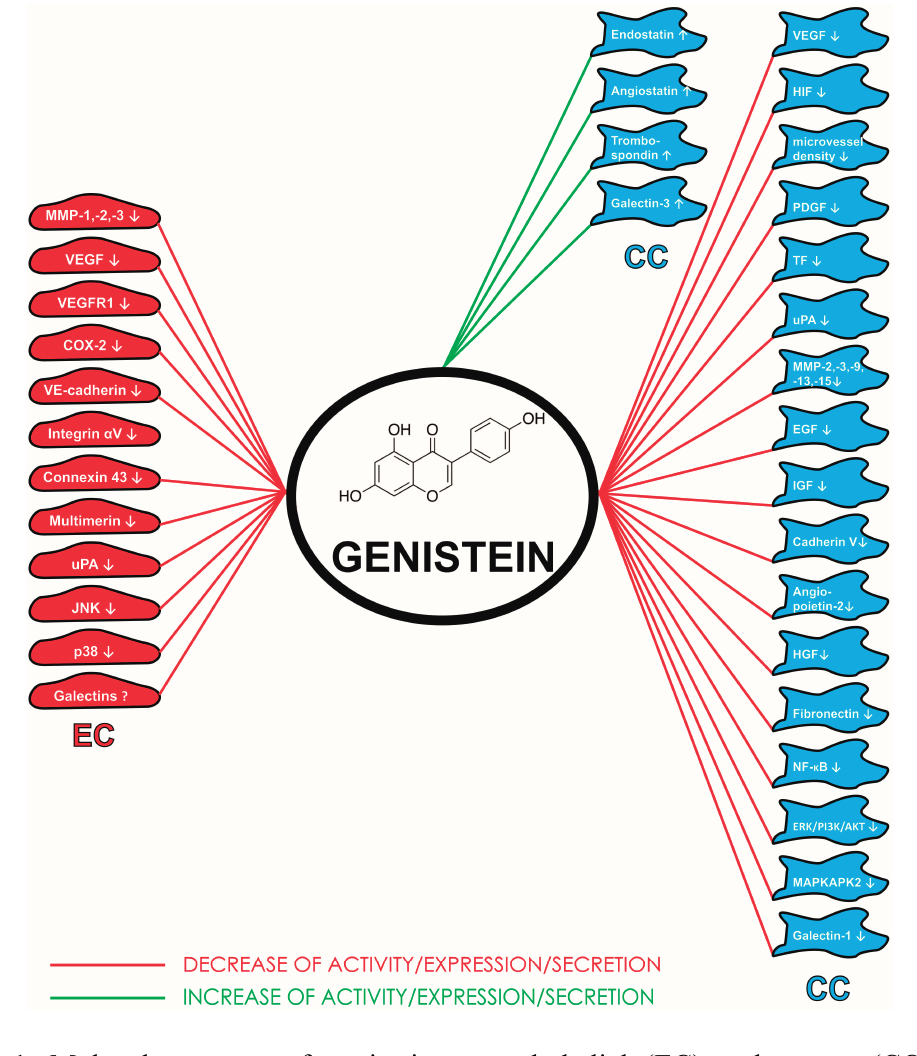
Figure 1. Molecular targets of genistein on endothelial (EC) and cancer (CC) cells. Akt-protein kinase B; bFGF—basic fibroblast growth factor; COX-2—cyclooxygenase-2; EGF—fibroblast growth factor; ERK—extracellular signal-regulated kinases; HIF—hypoxia inducible factor; IGF—insulin-like growth factor; JNK-c—Jun N -terminal kinases; MAPK— mitogen-activated protein kinase; MAPKAPK2—MAP kinase activated protein kinase 2; MMP-matrix metalloproteinase; NF- κ B—nuclear factor κ B; PDGF—platelet-derived growth factor; TF—tissue factor; TNF- α —tumor necrosis factors α ; uPA—urokinase plasminogen activator; VEGF—vascular endothelial growth factor; VEGFR1—receptor for vascular endothelial growth factor